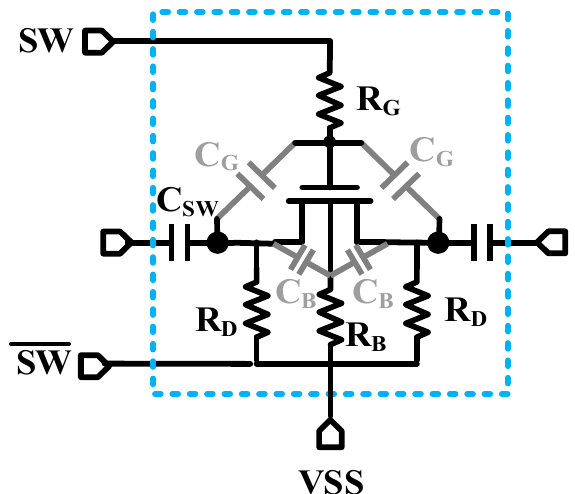
Figure 5. The switched capacitor structures.